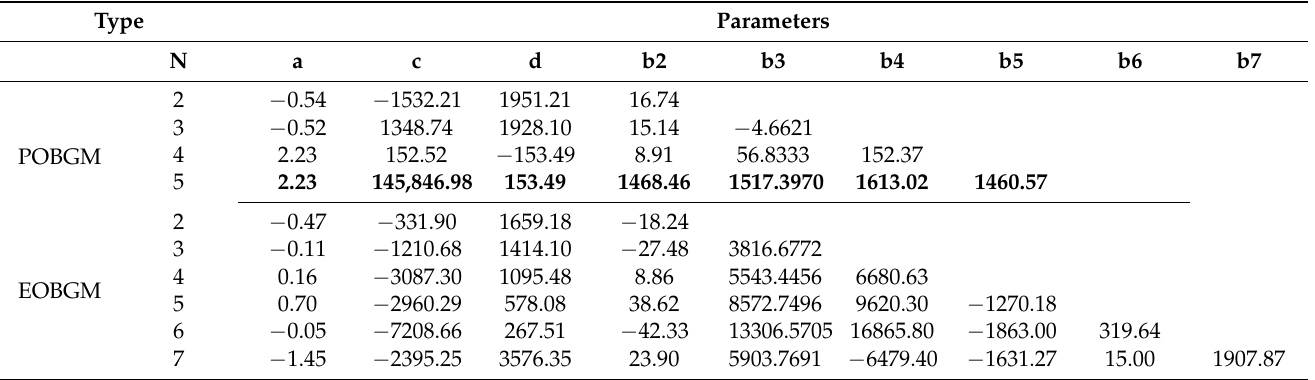
Table 5. The model parameters of multivariable grey models.